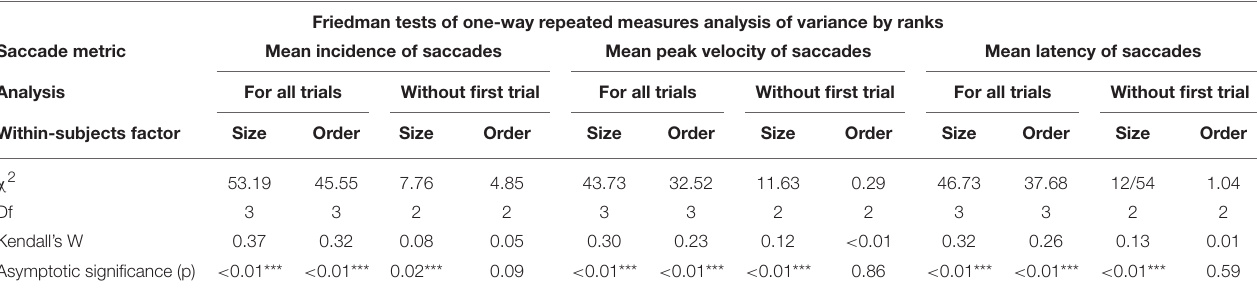
TABLE 4 | Repeated measures ANOVAs to investigate effects of target size and trial order. Friedman tests of one-way repeated measures analysis of variance by